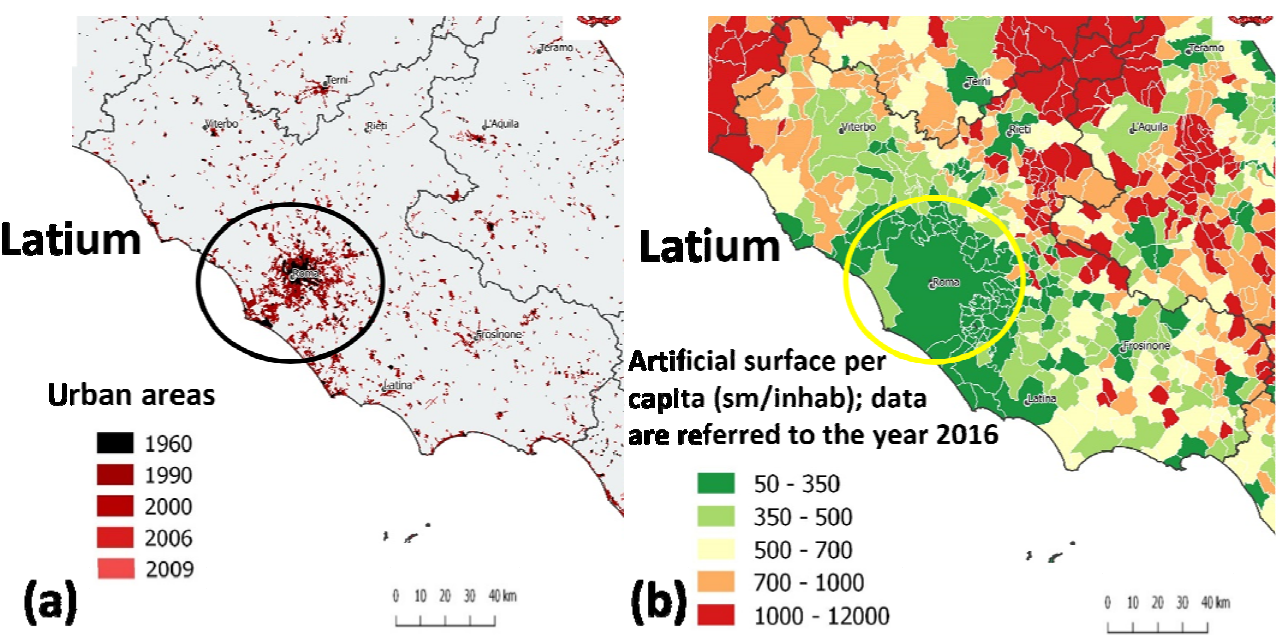
Figure 2. Boundaries of the Latium region located at the heart of Italy. Within the circle the municipalities of Rome and Fiumicino are shown with their corresponding urban areas (1960–2009, sub-figure ( a )) and 2016 artificial surface per-capita (sub-figure ( b )). These figures are taken from the annual report (2017) that ISPRA (Italian National Institute for Environmental Protection and Research) draws up on soil consumption, territorial dynamics and ecosystem services